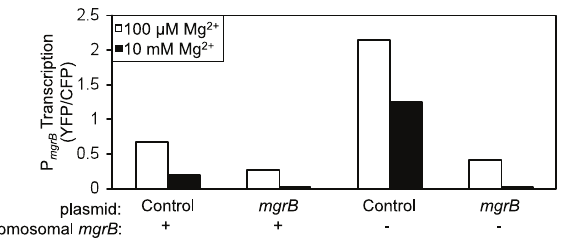
Figure 2. Expression of mgrB from a plasmid complements a chromosomal deletion. Reporter strains for mgrB transcription are either wild-type for the chromosomal mgrB (TIM92) or contain a deletion (AML20) and either a control plasmid (pEB52) or a plasmid bearing mgrB (pAL8). Cells were grown in minimal glucose medium with 100 m M (white) or 10 mM (black) MgSO 4 . Cellular fluorescence was measured by microscopy and image analysis as described in Materials and Methods. The error bars represent the range of means for two independent cultures.